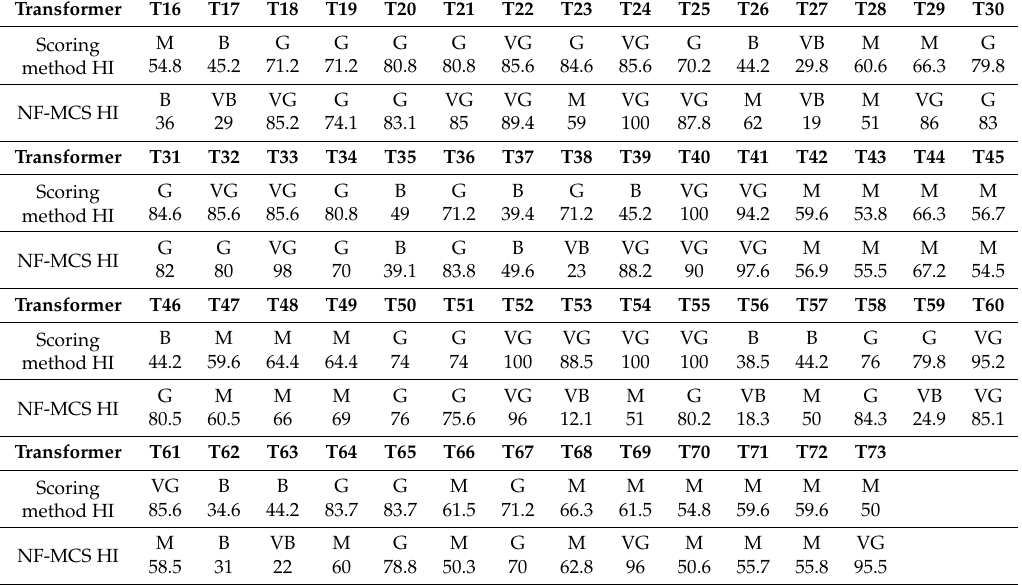
Table 2. HI and assessments of transformers based on scoring and NF-MCS methods (58 transformers).